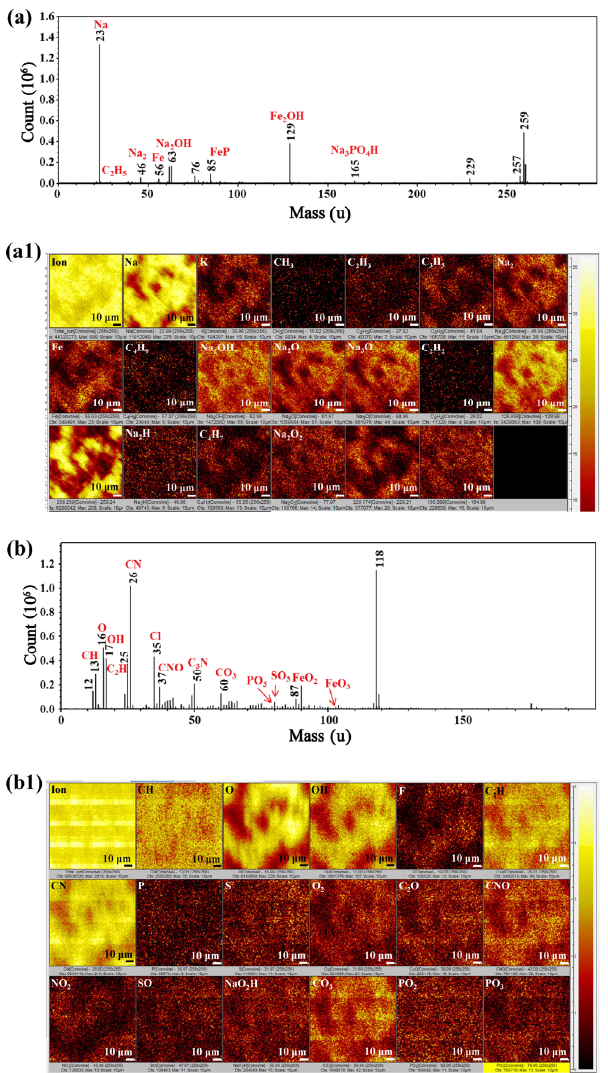
Fig. 10 (a and b) TOF-SIMS mass spectrometry and (a1 and b1) two-dimensional TOF-SIMS imaging of positive and negative ions generated by friction films on steel wear surfaces under water lubrication containing 1 wt% BTA-P 4444 -Lig at 50 °C